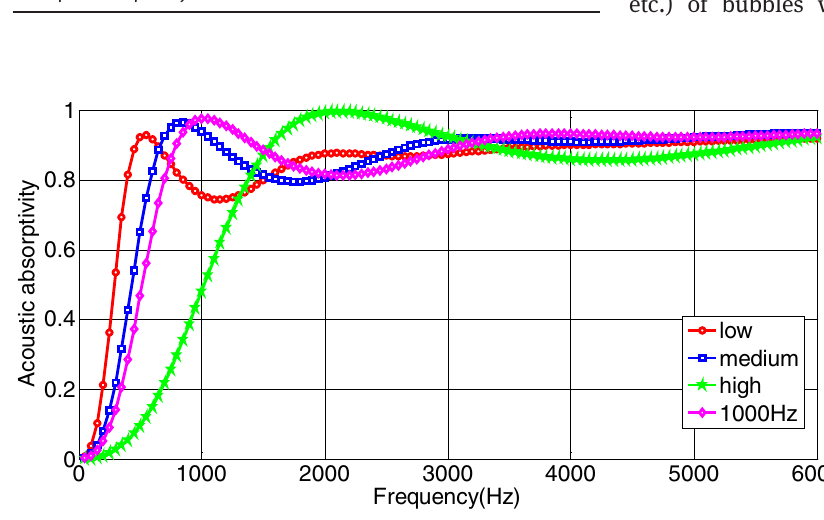
Figure 6: On-demand optimization results for PM at different frequency bands and fixed point